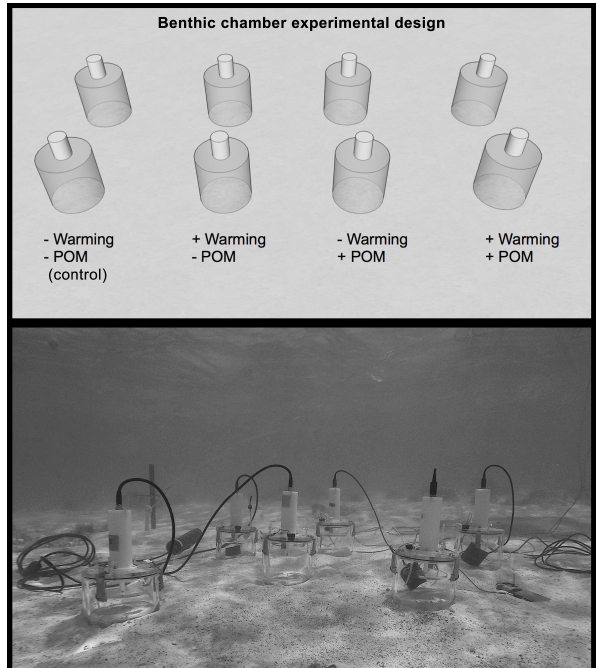
Figure 1. Layout of the experimental design using benthic cham- bers. Eight chambers were used in total, which provided two repli- cates per treatment. Chambers are organised by the presence ( + ) and absence ( − ) of the warming ( + 2.4 ◦ C) and organic matter (OM; phytodetritus or coral mucus)